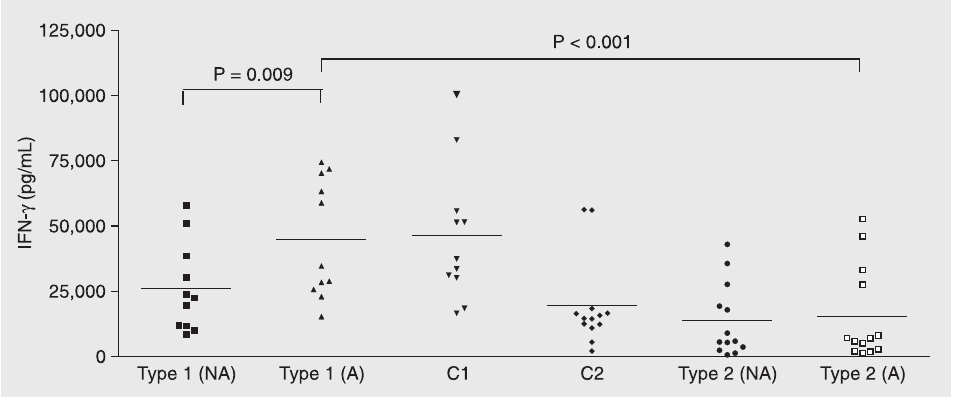
Figure 2 . INF- γ levels in culture supernatants of peripheral blood mononuclear cells from type 1 and 2 diabetic patients having inadequate (NA) or adequate (A) metabolic control and normal individuals (control 1 (C1) and control 2 (C2) paired by sex and age with type 1 and 2 diabetic patients, respectively). INF- γ levels were higher in